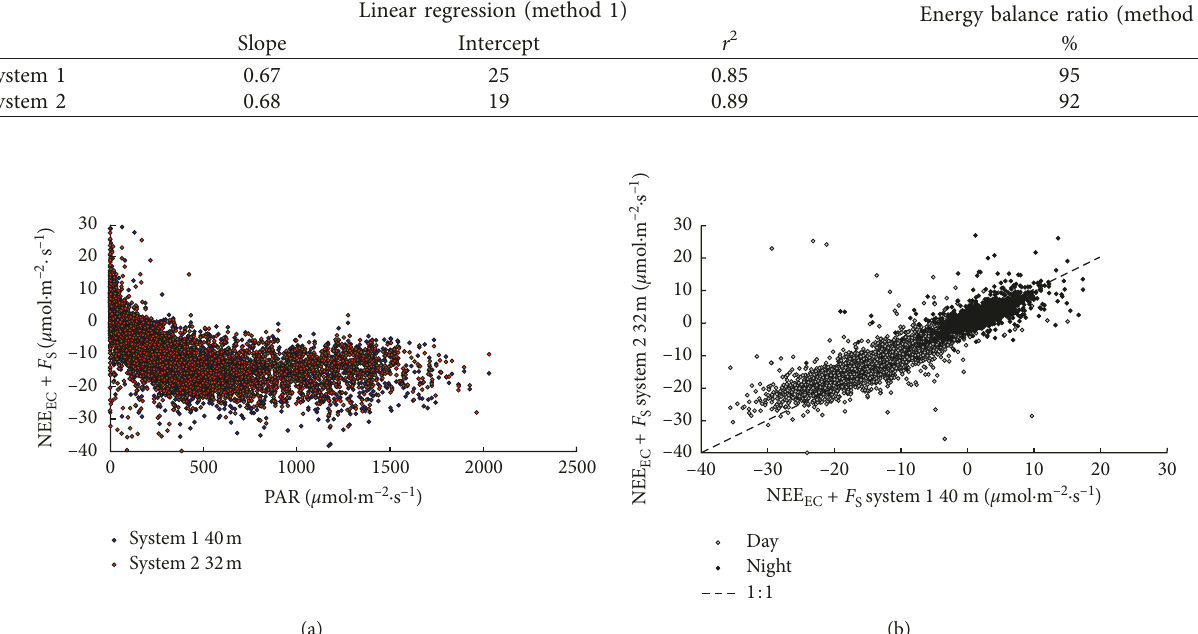
N − B S and H + LE. Method 2: energy balance ratio over all data for